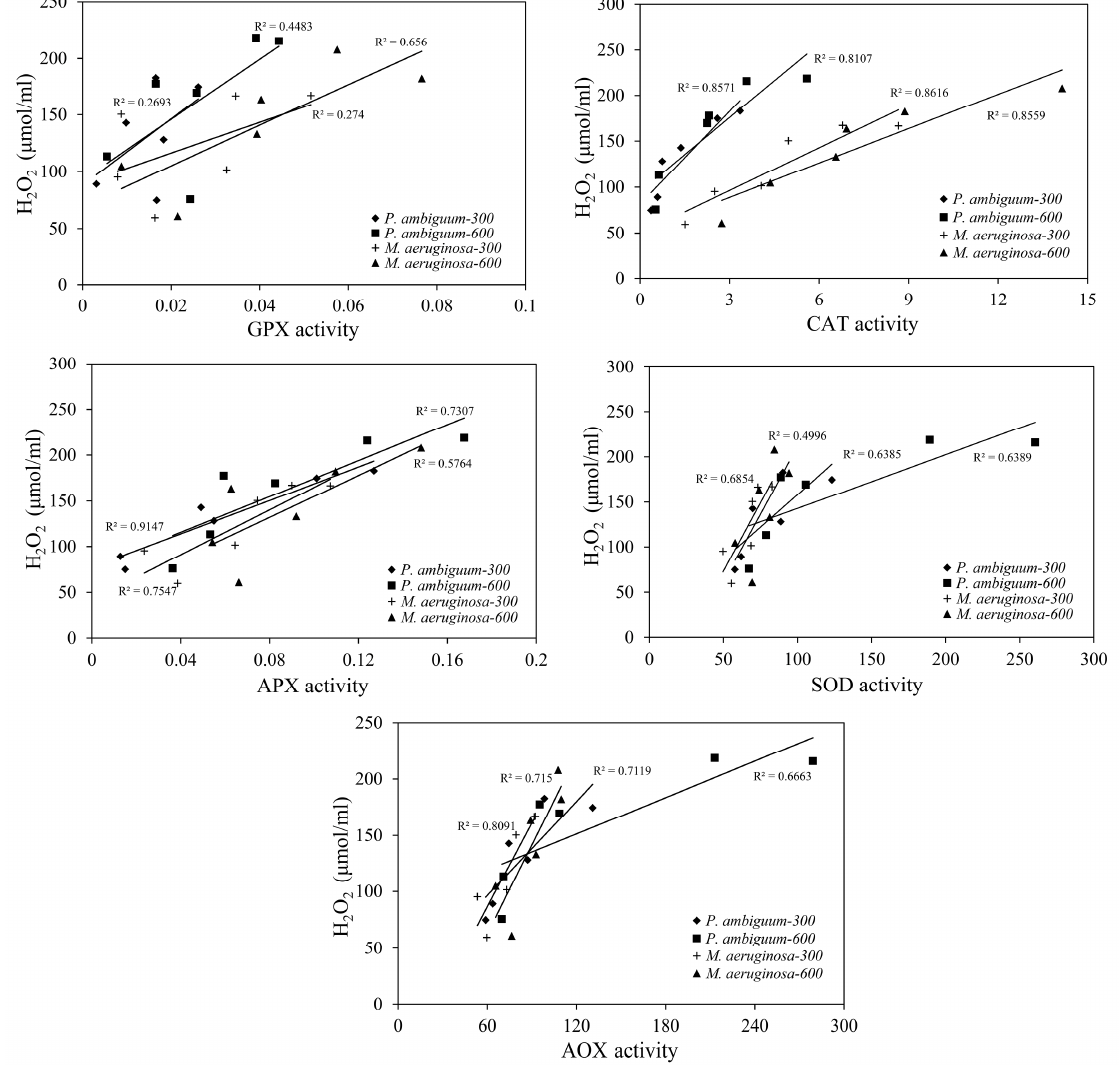
Figure 7. Linear regression relationships between the H 2 O 2 contents and the antioxidant activities (GPX, CAT, APX, SOD, and AOX) of P. ambiguum (strain NIES 2119) and M. aeruginosa (strain NIES 111). The numbers 300 and 600 represent the maximum PAR intensities (in µ mol · m − 2 · s − 1 ) for two different treatment conditions, where the maximum PAR intensity was reached at 12:00 h. Table 1. Pearson’s correlation test results of the correlation between H 2 O 2 and antioxidant levels, i.e., guaiacol peroxidase (GPX), catalase (CAT), ascorbic peroxidase (APX), super oxidase dismutase (SOD), and total antioxidants (AOX).